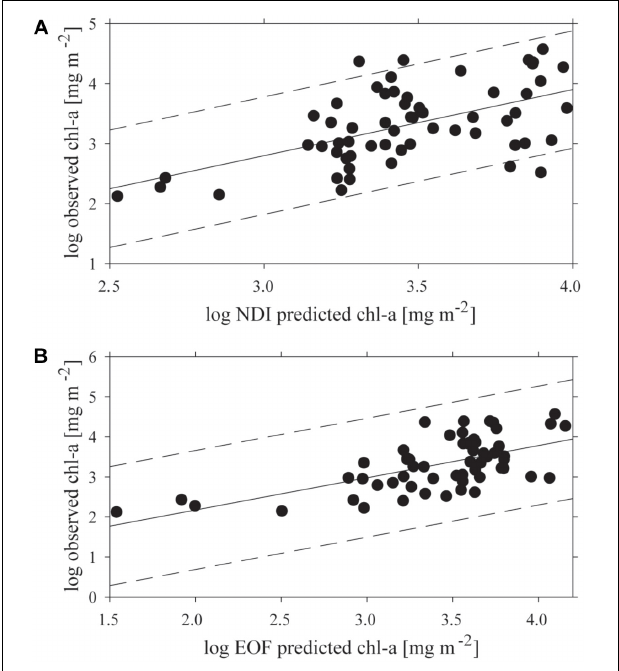
FIGURE 4 | The relationship between predicted and observed chl-a concentrations (mg m - 2 ) applying: (A) the normalized difference indices (NDI) 402:530 nm, and (B) the empirical orthogonal function analysis (EOF) both with a 95% confidence interval.